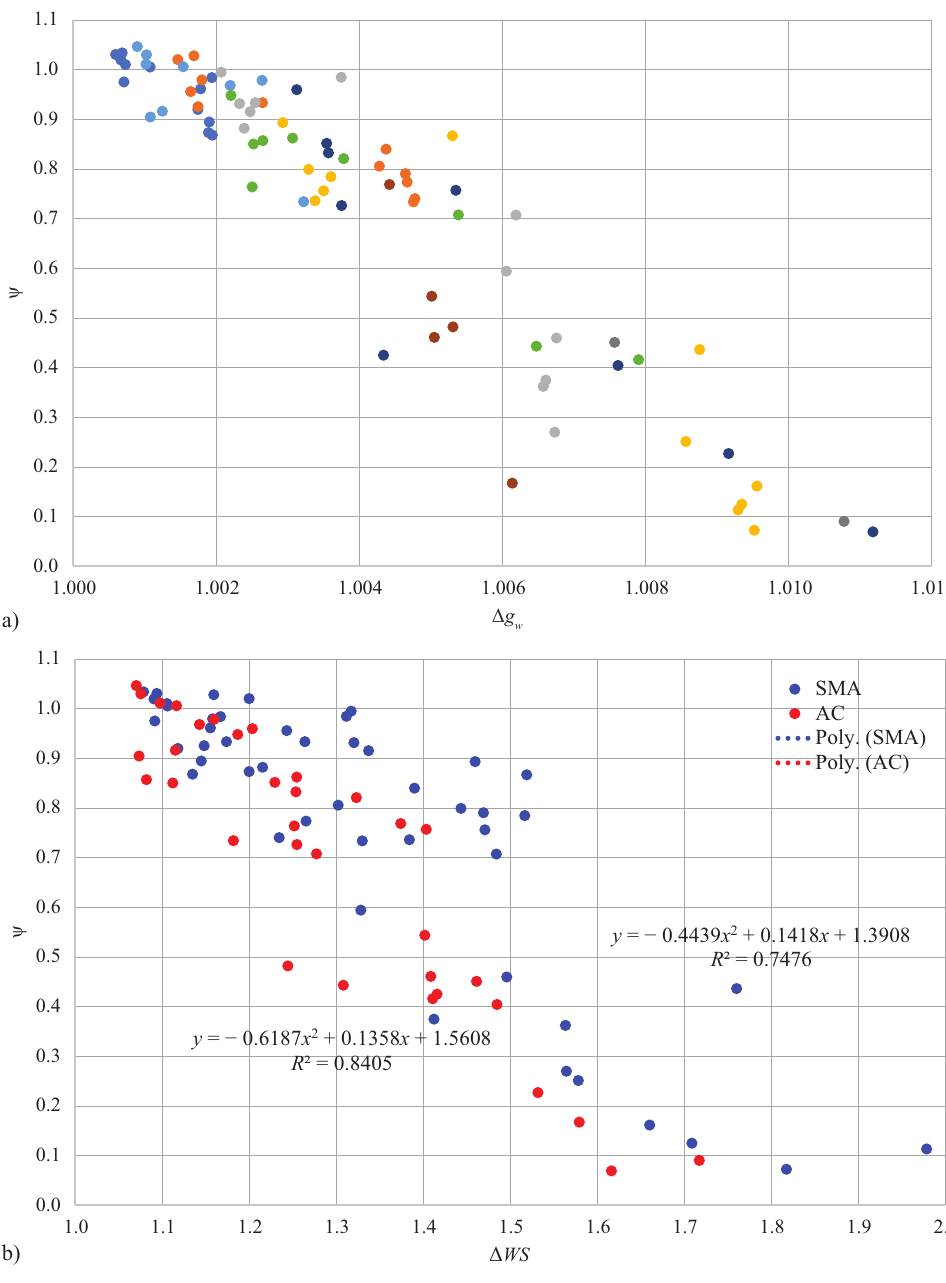
Figure 5. Change in water saturation characteristics of the samples depending on the asphalt concrete damageability